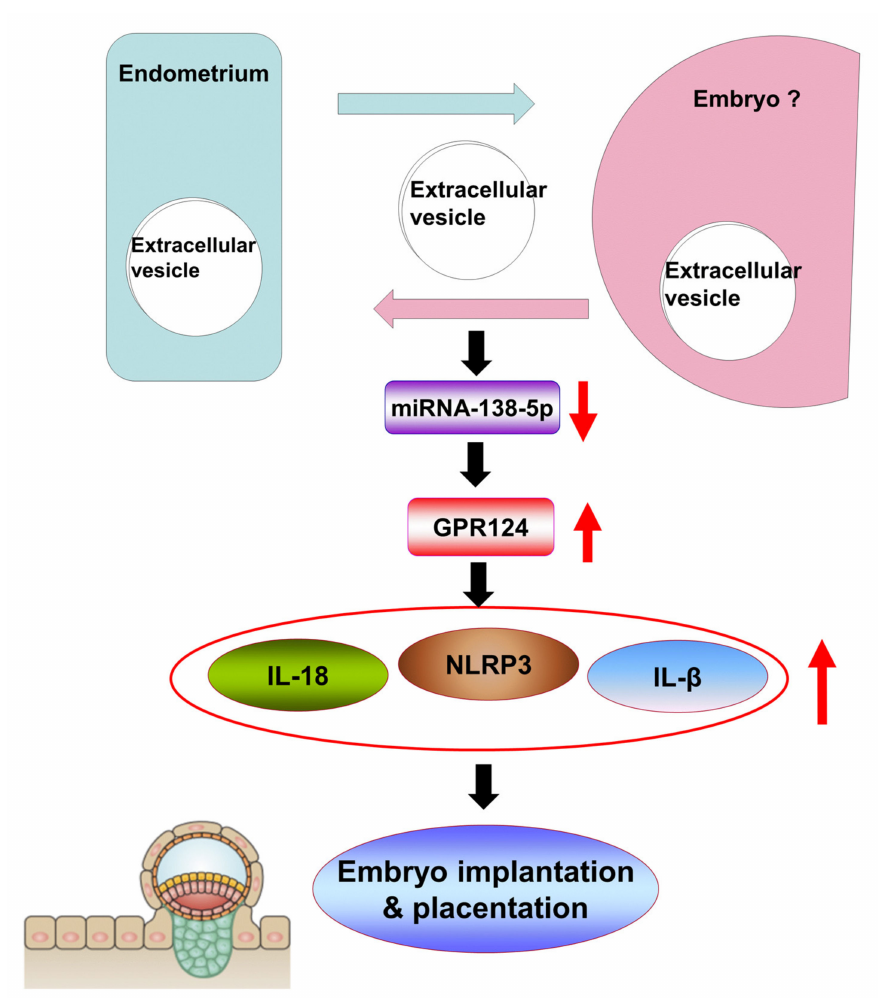
Figure 7. The proposed signaling pathways involved in the role of extracellular vesicles, miR-138-5p, GPR124, and NLRP3 inflammasome in normal early pregnancy and spontaneous miscarriage. These results demonstrate an important function for mi138-5p in regulating the embryo implantation and early pregnancy, through the modulation of GPR124, and the following activation of inflammasome NLRP3, IL-18, and IL-1 β